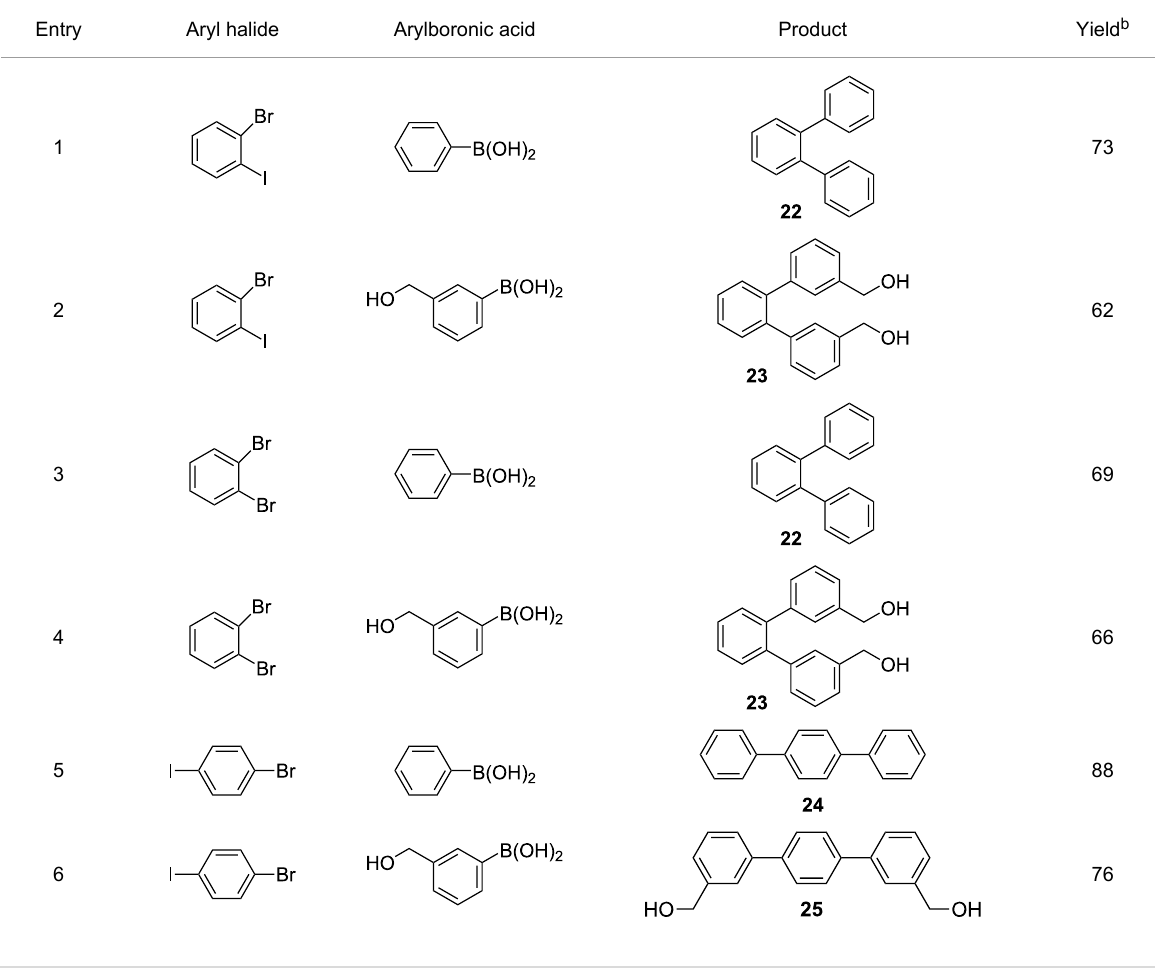
Table 5: Suzuki cross coupling reaction of di- and trihaloaryls with arylboronic acid a .